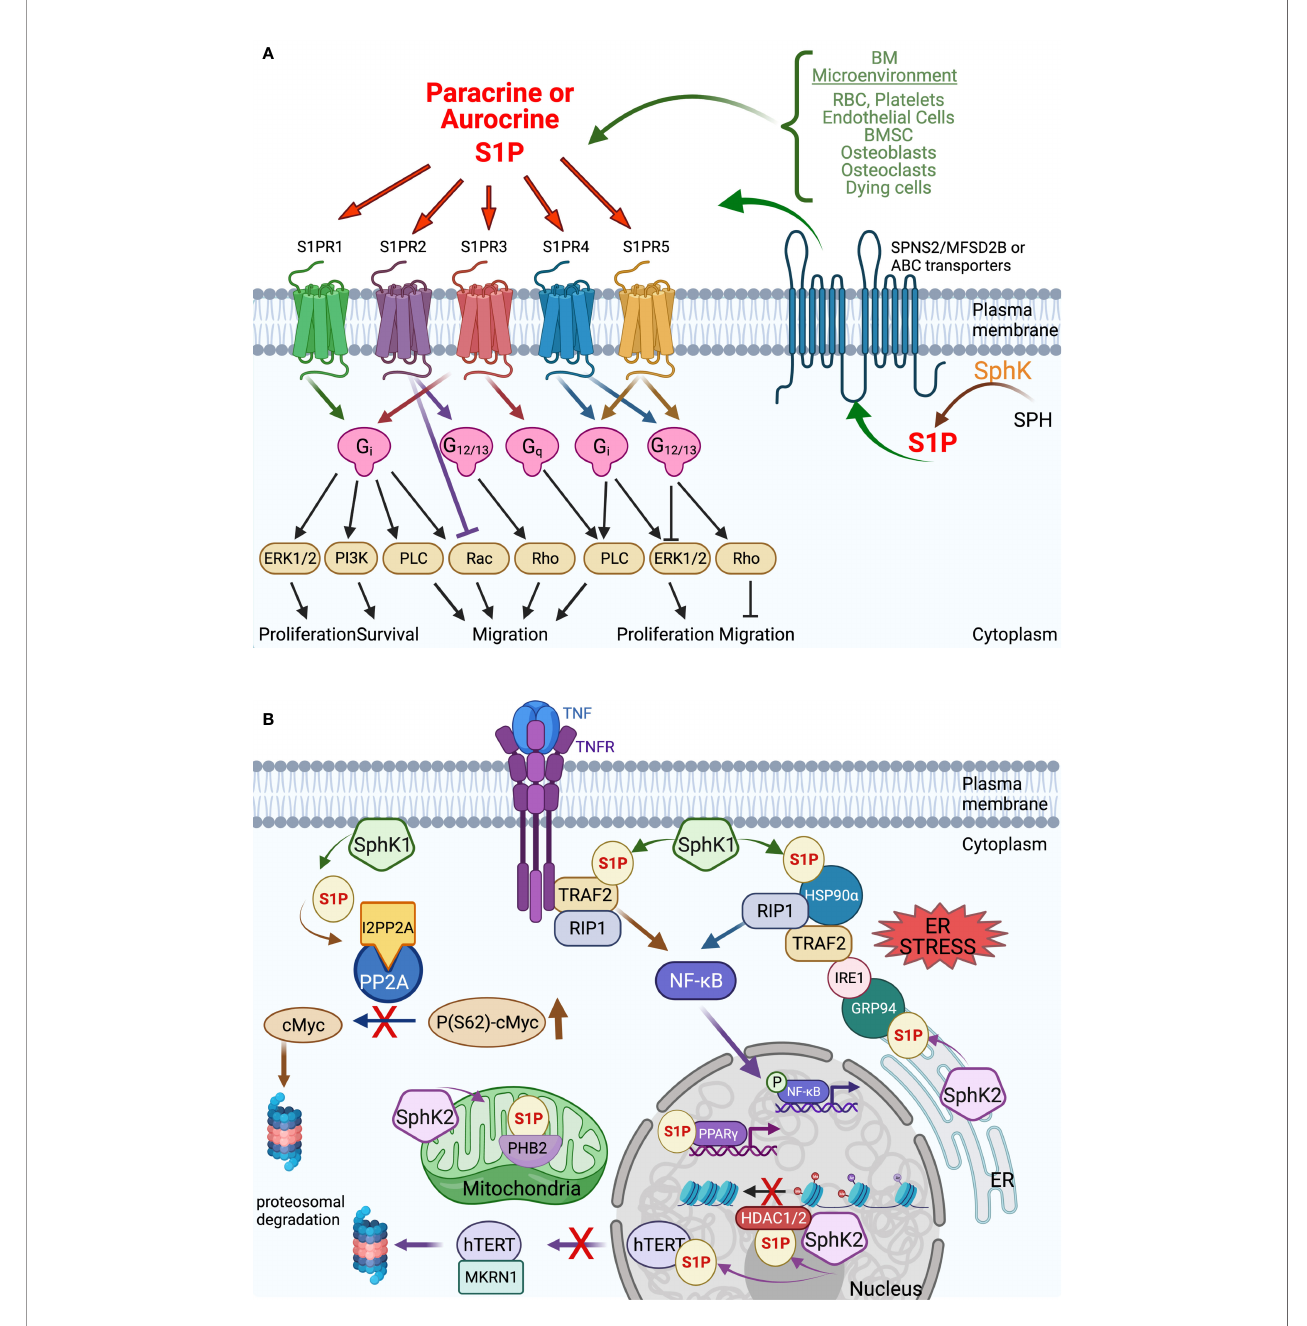
FIGURE 2 | Extracellular and intracellular S1P signaling in the tumor microenvironment. (A) Extracellular S1P acts in both autocrine and paracrine by interaction with the 5 S1P G-protein coupled receptors S1PR1-5 to induce an array of downstream signaling with a variety of cellular effects that can vary between cell types. The export of intracellularly produced S1P occurs via several transporters from the MFS family (SPNS2, MFSD2B) and the ABC family that also varies by cell type. See text for details. (B) Intracellular S1P acts in receptor-independent manners to regulate a variety of proteins – their stability or activation – with effects on cellular functions including gene transcription, chromatin stability, mitochondrial respiration that affect cell viability and longevity. Some examples: S1P generated by HDAC1/ 2-bound SphK2 binds and inhibits HDAC1/2, thereby opening the chromatin for more gene transcription. The direct interaction of S1P with the transcription factor PPAR g activates it to interact with its gene targets (33). Under ER stress, S1P interacts directly with chaperones HSP90 a and ER-localized GRP94 to trigger the formation of a large complex that includes IRE1, TRAF2, and RIP1 to activate NF- k B (34). S1P has also been reported to interact with TRAF2 during TNF signaling to activate NF- k B via RIP1 (35). S1P promotes cell viability by indirectly stabilizing cMyc by preventing dephosphorylation by protein phosphatase 2A (PP2A) via increasing interaction with the PP2A inhibitor I2PP2A (36, 37). S1P also increases cell longevity by directly interacting with telomerase reverse transcriptase (hTERT) to prevent interaction with MKRN1 and nuclear export to the proteasome (38). Direct interaction of S1P with the mitochondrial protein prohibitin 2 (PHB2) stabilizes it and enhances mitochondrial respiration (39) (created with